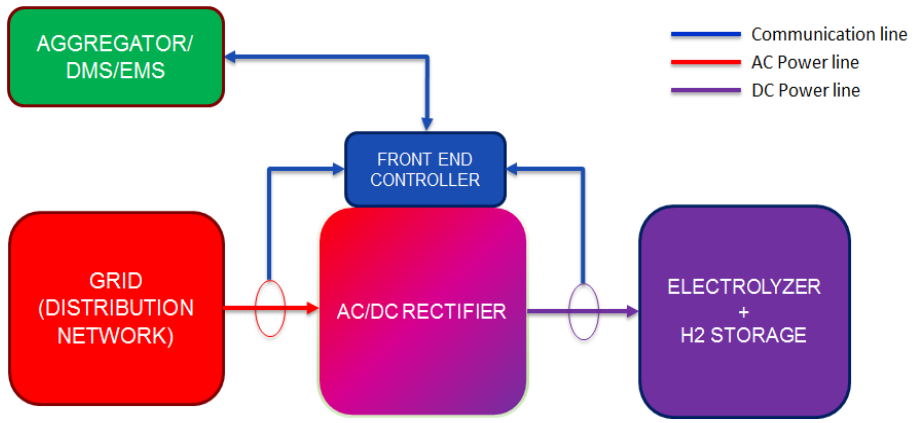
Figure 1. Proposed front end controller (FEC) with controllable electrolyzers as an